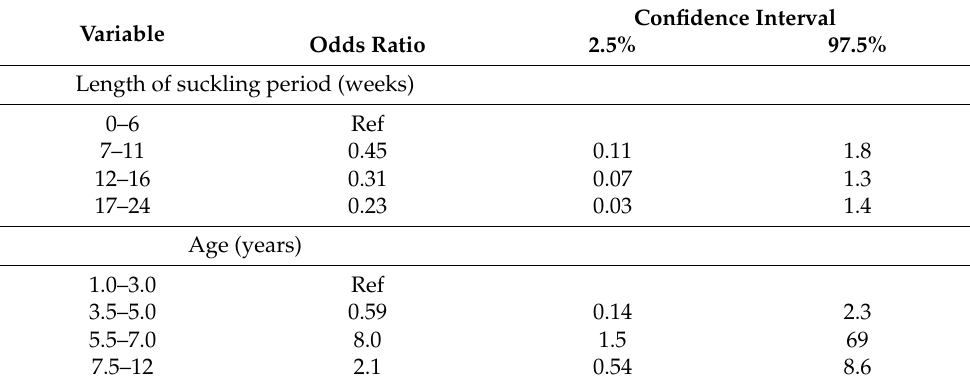
Table 3. Final multivariable model * of the cats ( n = 69) with adjusted odds ratios and 95% confidence intervals for